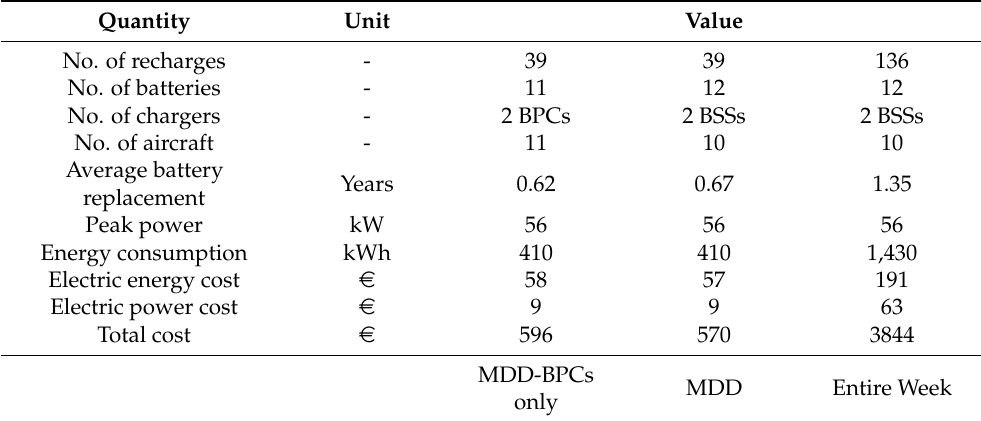
Table 8. LIMB infrastructural sizing